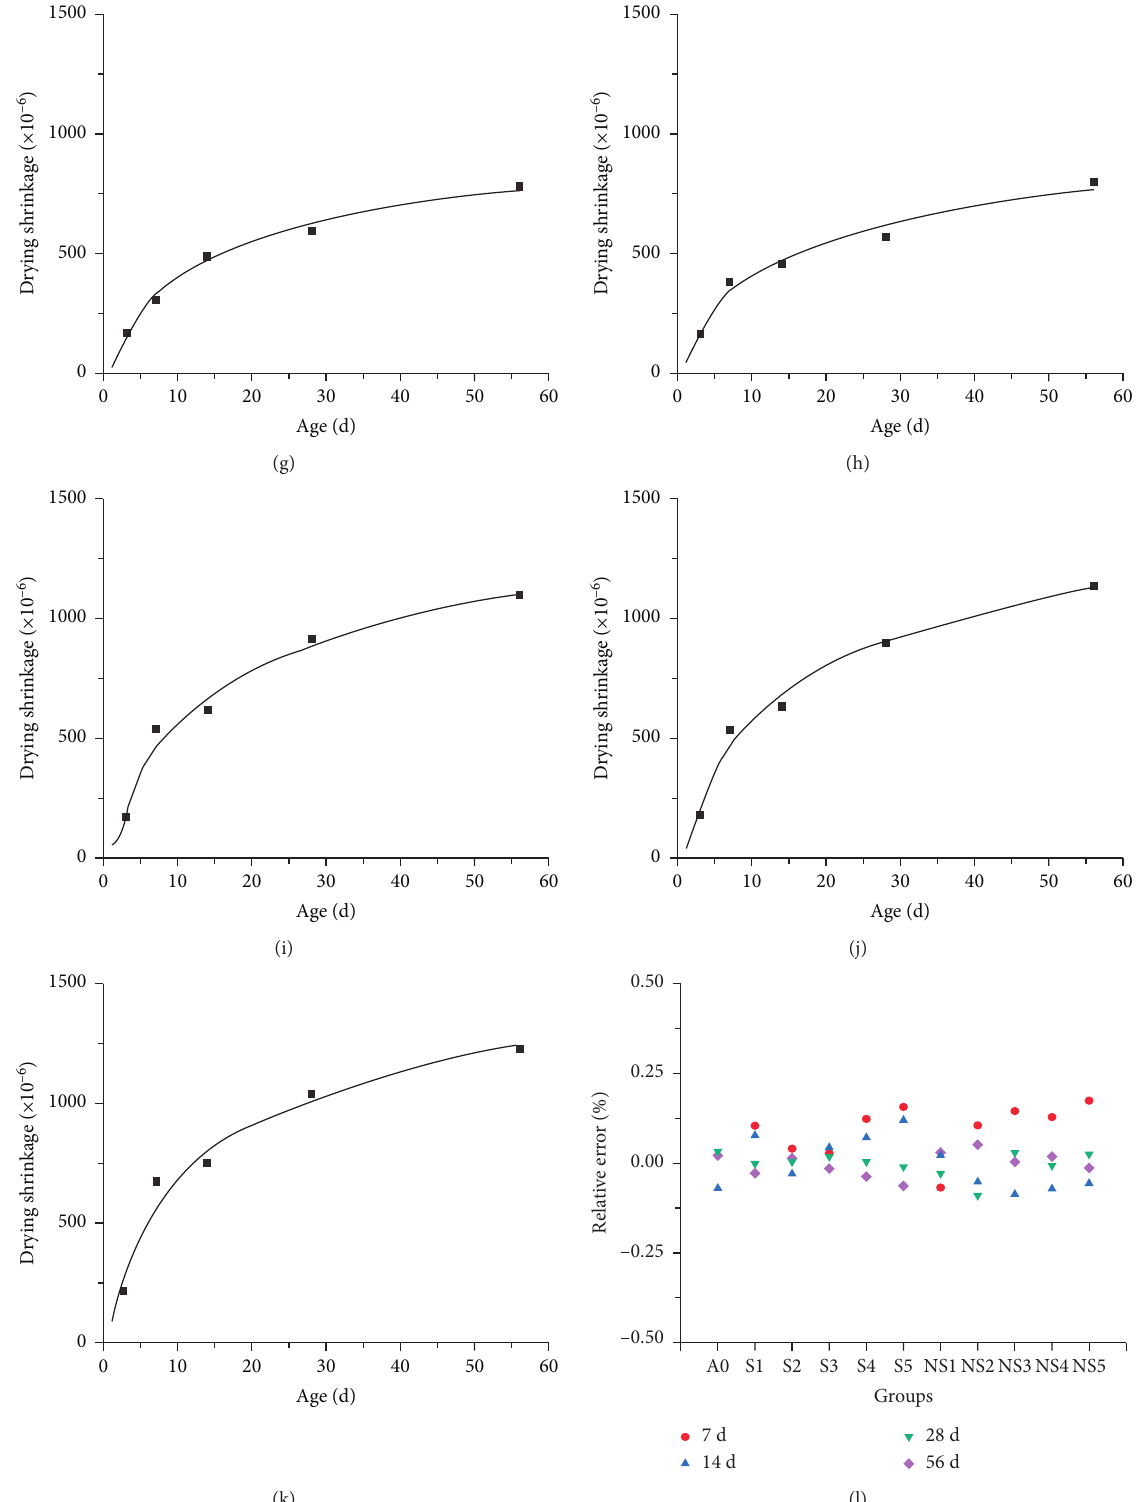
Figure 7: Effects of age on drying shrinkage and relative error. (a) A0 (0%). (b) S1 (5% SF). (c) S2 (10% SF). (d) S3 (15% SF). (e) S4 (20% SF). (f) S5 (25% SF). (g) NS1 (0.5% NS). (h) NS2 (1% NS). (i) NS3 (1.5% NS). (j) NS4 (2% NS). (k) NS5 (3% NS). (l) The relative